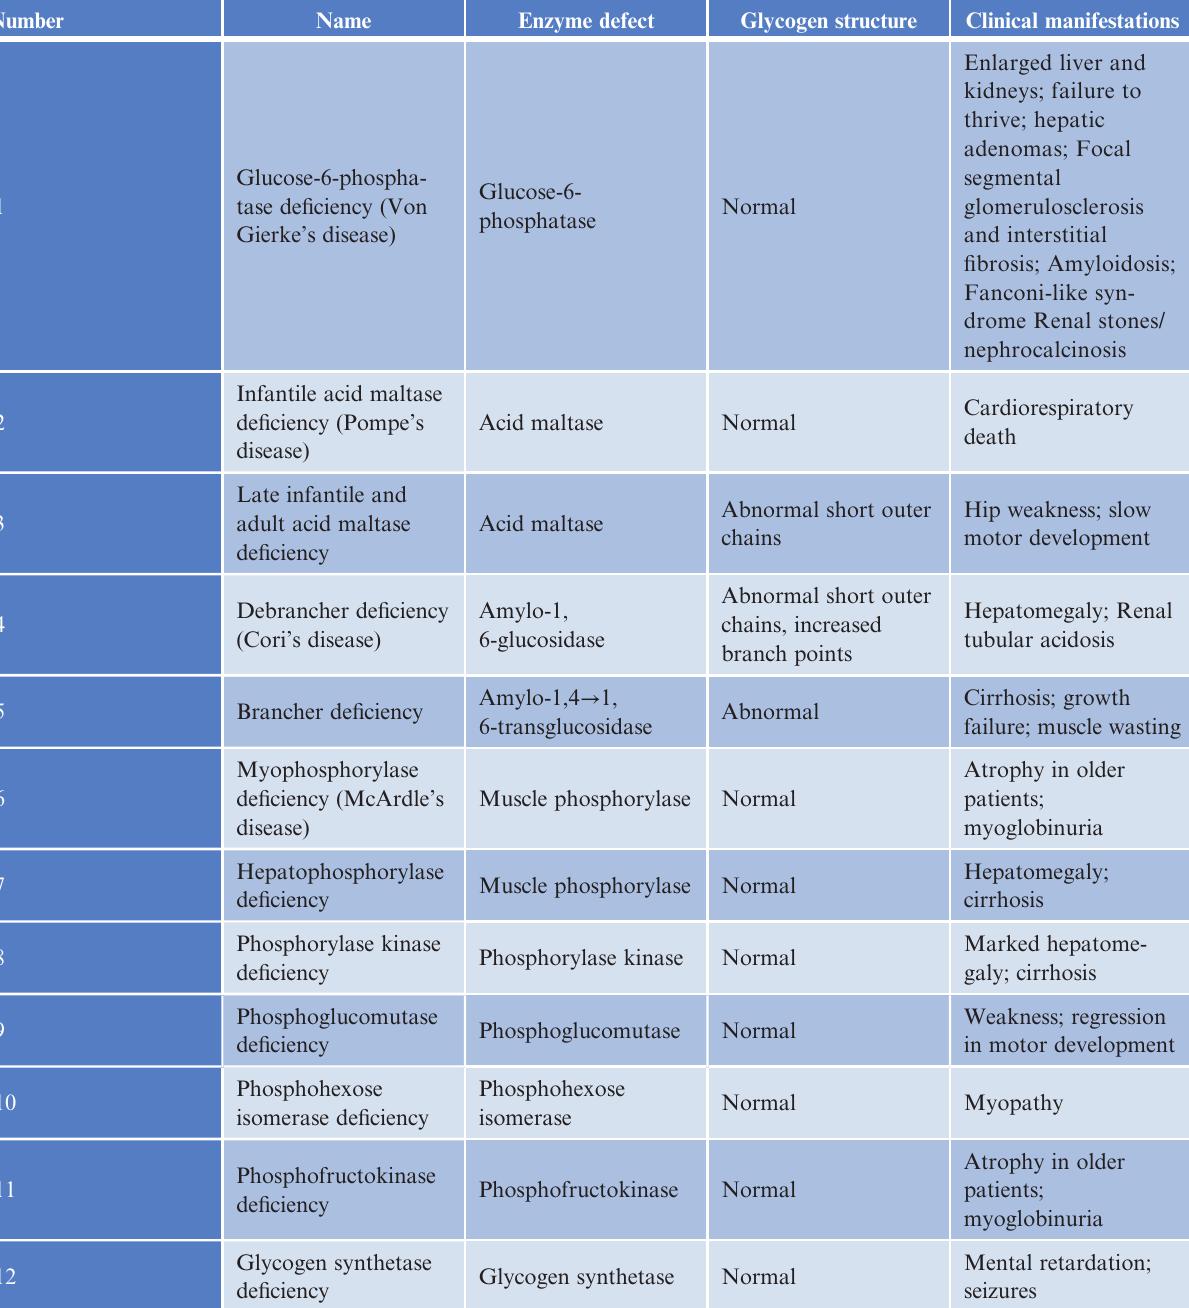
Table 5. Different types of glycogen storage diseases and main clinical fi ndings